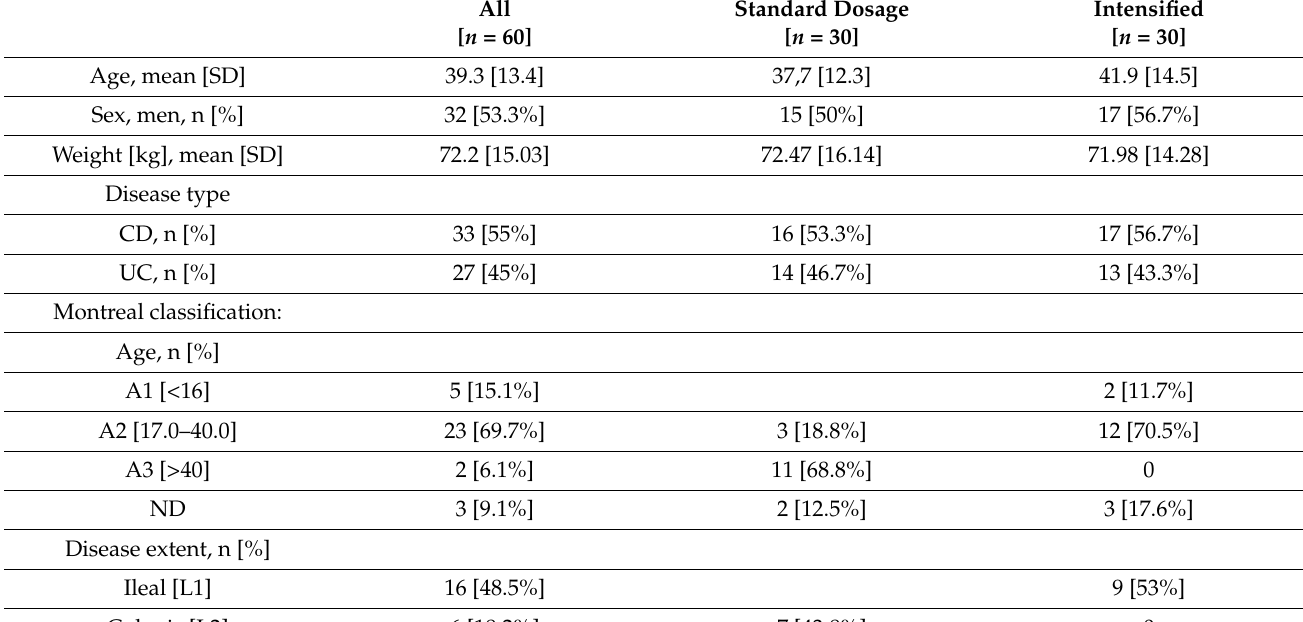
Table 1. Baseline characteristics of patients switched to SC